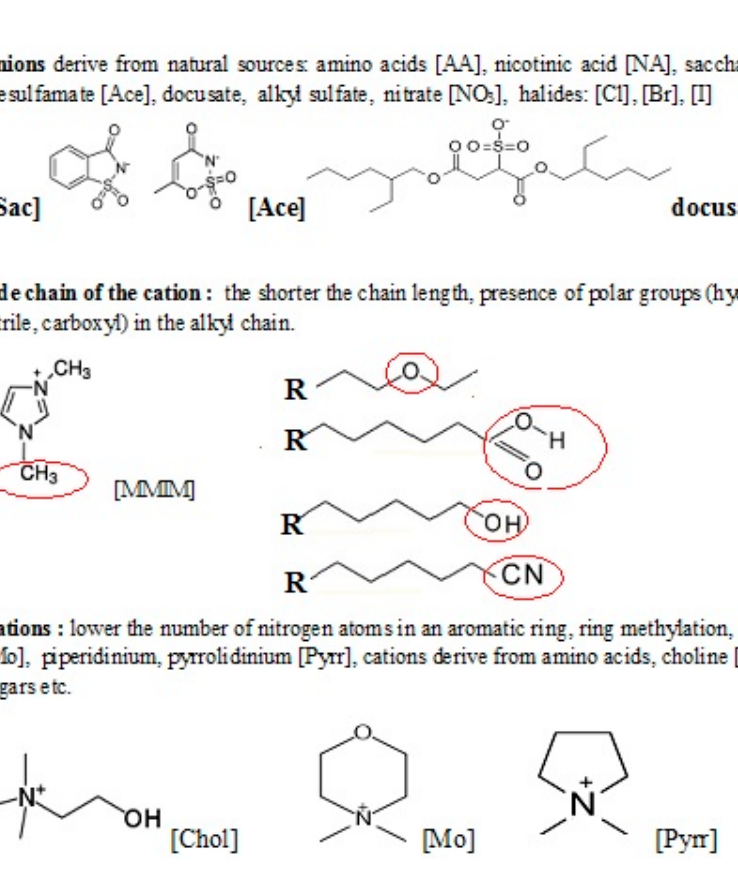
Figure 1. Chosen substructures of ILs influencing their